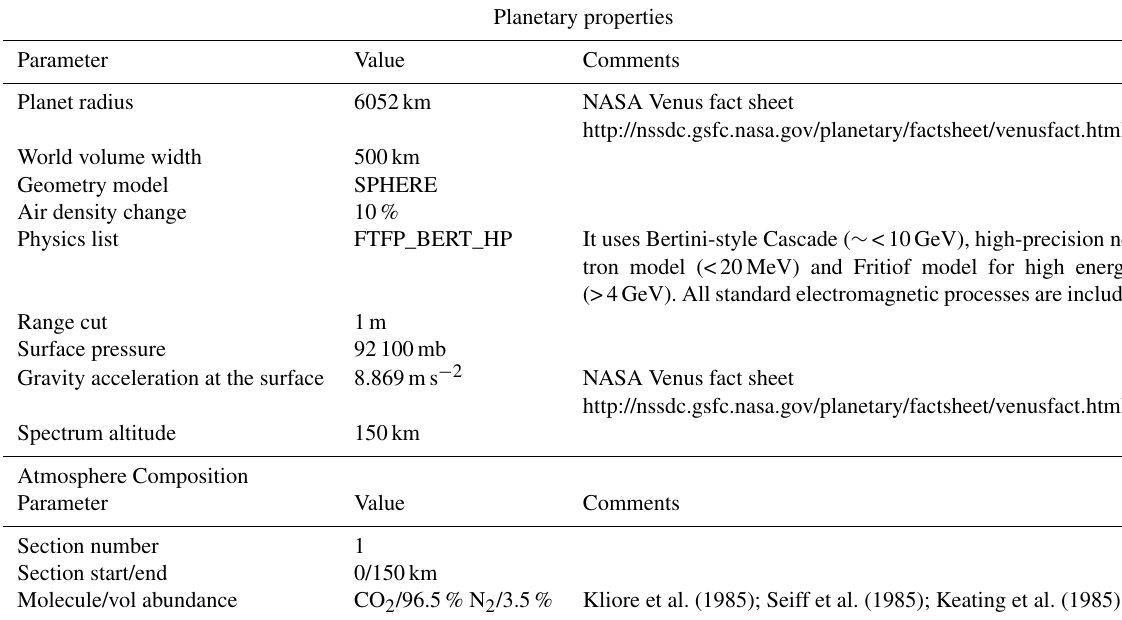
Table 1. Input parameter values considered in DYASTIMA during its application to the Venusian atmosphere, for solar minimum and solar maximum